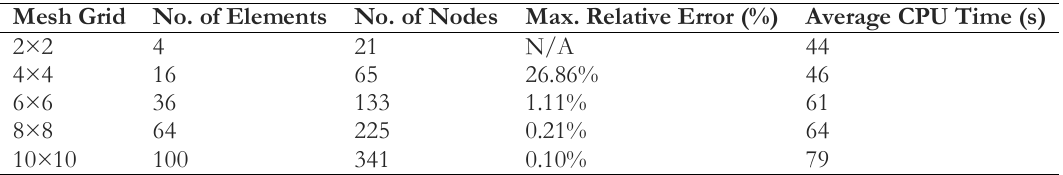
Table 3. Variation of maximum relative approximate percent error and CPU time with plate’ s mesh grid for isotropic